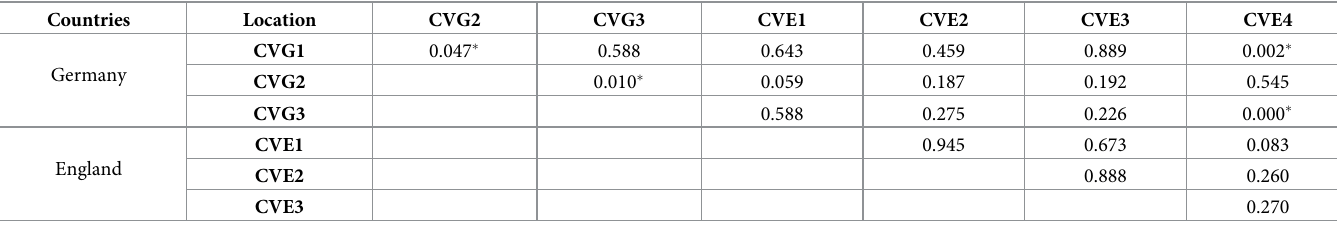
Table 4. Statistical analysis comparison of wing size variation of C . vicina in 7 sampling areas. Countries